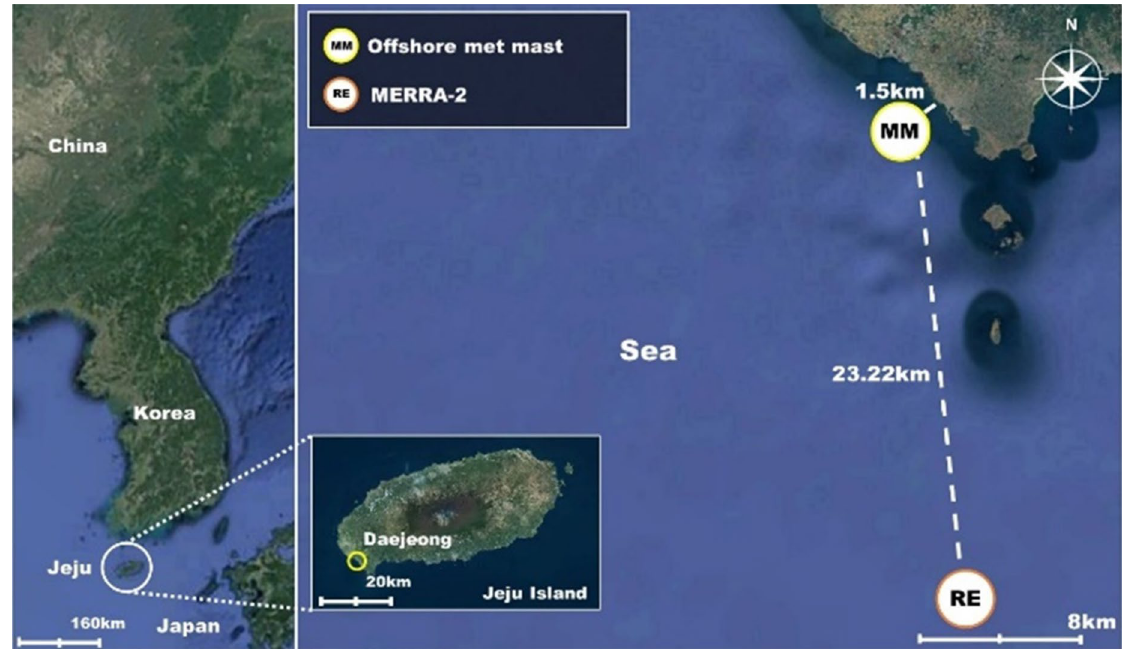
Figure 1. Location of Jeju Island and Daejeong area including offshore met mast and MERRA-2 reanalysis data points (satellite image: created using Google Earth Version 9, https:// earth. google.